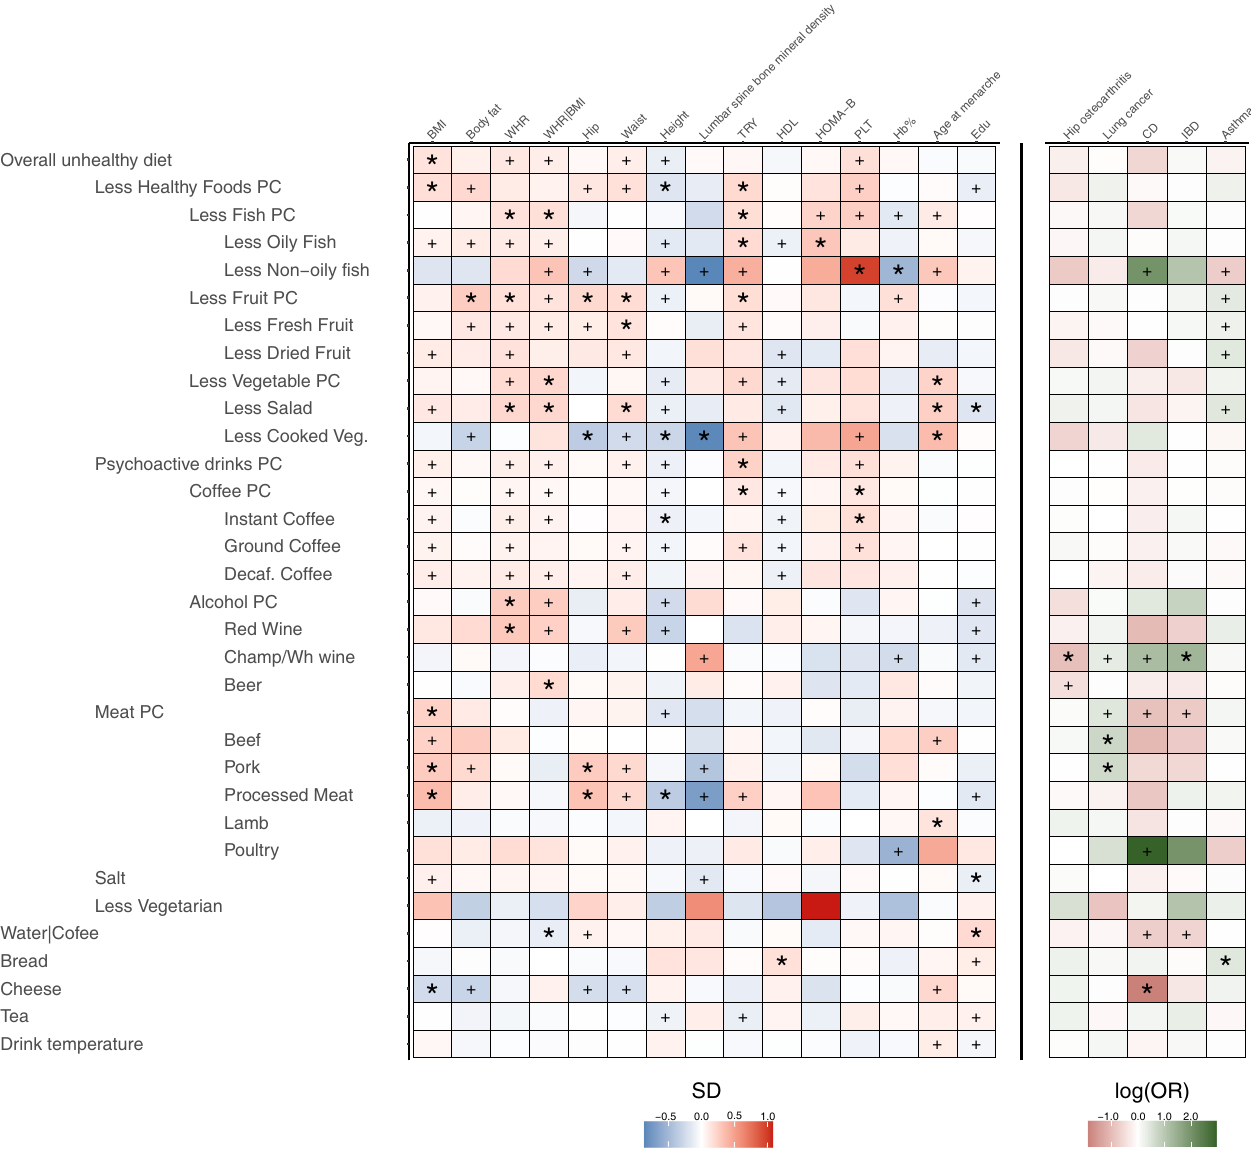
Fig 6. Significant effects of food choice on disease related traits. The heatmap reports the results for all significant food trait exposure trait outcome. Only dietary pattern exposures summarising the overall group consumption (PC1) have been reported. All exposures have been aligned to have a positive loading onto the “overall unhealthy diet” measure. Significant food/trait association are indicated with � . Abbreviations: BMI Body Mass Index, WHR Waist to Hip Ratio, TRY triglycerides, TC total cholesterol, HDL HDL cholesterol, LDL LDL cholesterol, Hb% Haemoglobin percentage, PLT Platelet count, Edu Educational attainment, CD Chron’s Disease, IBD Inflammatory Bowel Disease. Panel has been divided in two to separate quantitative traits where effect size is in SD outcome per SD exposure (higher effect equals red colour) from qualitative traits where effect sizes are expressed in log(OR outcome) per SD exposure (higher effect equals green colour). when applying the filtering approach (beta 0.05 (SE 0.02) uncorrected and 0.05 (SE 0.06) corrected), suggesting that our approach could precisely identify relevant biological relationships. A full description of our findings is found in Table T in S1 Table and have been made avail- able through an online app (https://npirastu.shinyapps.io/Food_MR/).